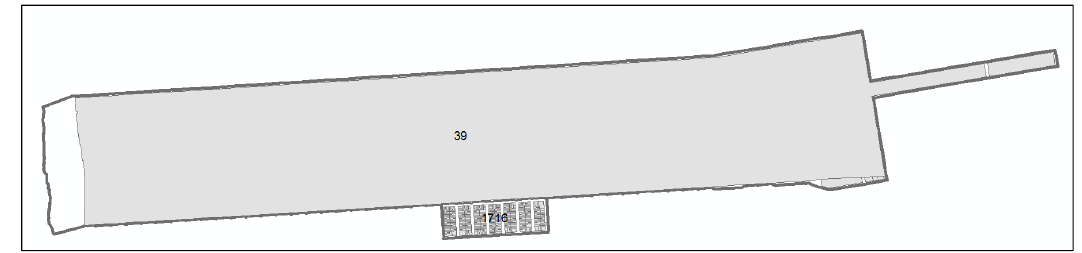
Figure 2. An example where areal weighting will result in poor estimates.